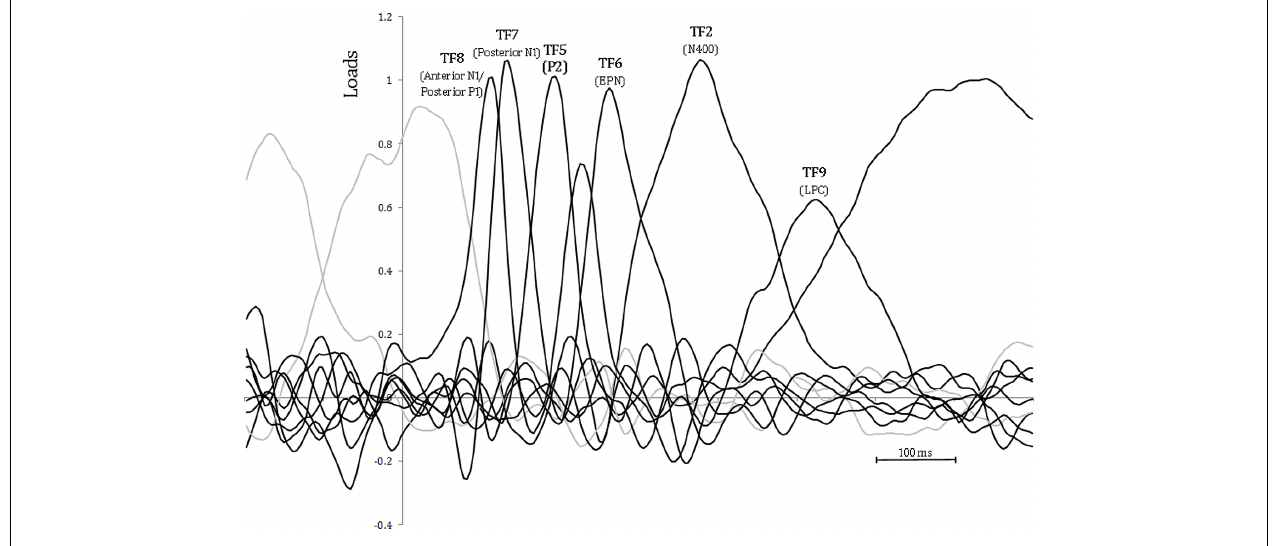
FIGURE 4 |Temporal principal component analysis (tPCA): factor loadings after Promax rotation. Peak-latency of relevant factors is shown.